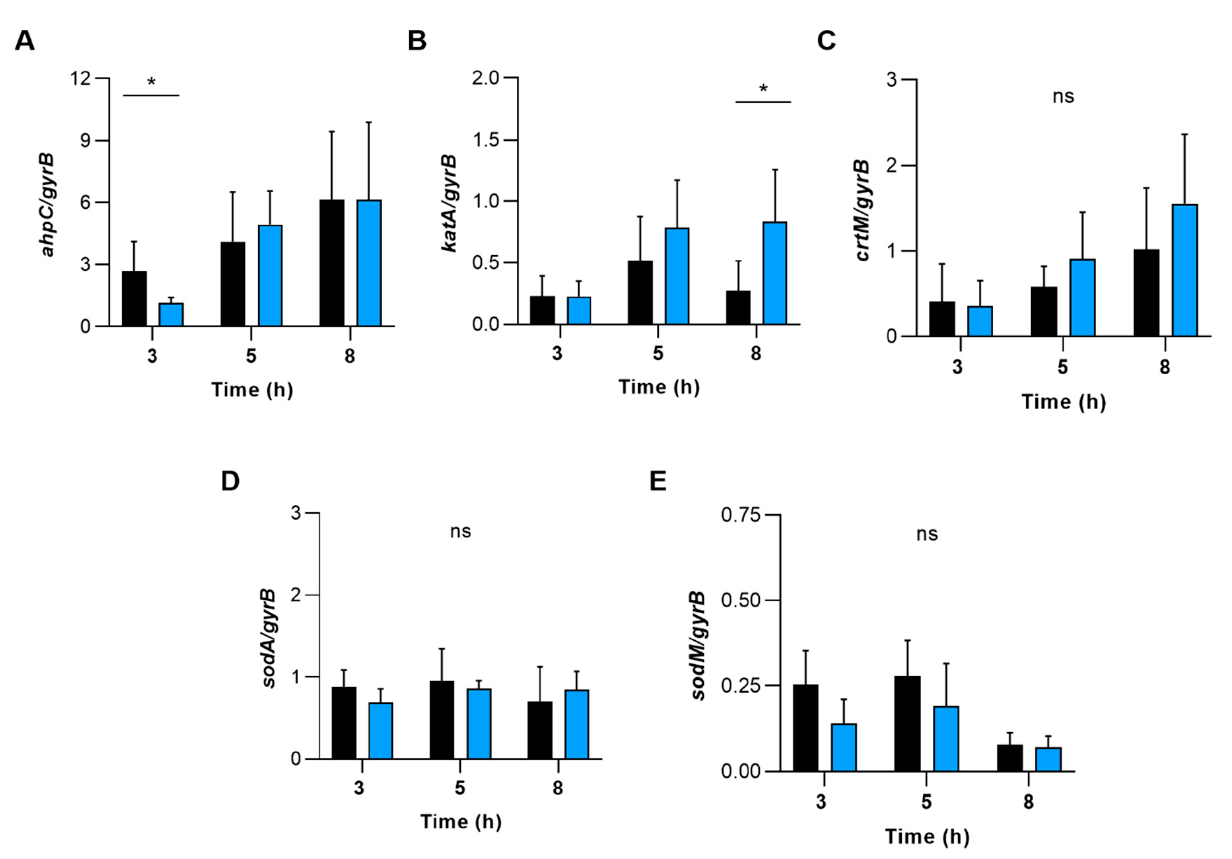
Figure 9. The effect of deleting the sapS gene in S. aureus on the transcription of genes that code for enzymes involved in the detoxification of reactive oxygen species (ROS). qRT-PCR was used to conduct quantitative transcript analyses of ahpC ( A ), katA ( B ), crtM ( C ), sodA ( D ) and sodM ( E ) in SA564 (black bars) and SA564 ∆ sapS (blue bars) cells cultured in TSB at 37 ◦ C and 225 rpm at the time points indicated. Quantification of the transcripts was performed in relation to the transcription of gyrase B (in copies per copy of gyrB ). The data are shown as mean + SD of five biological replicates. ns, not significant; * p < 0.05 (Mann-Whitney U test between WT and mutant at a given time